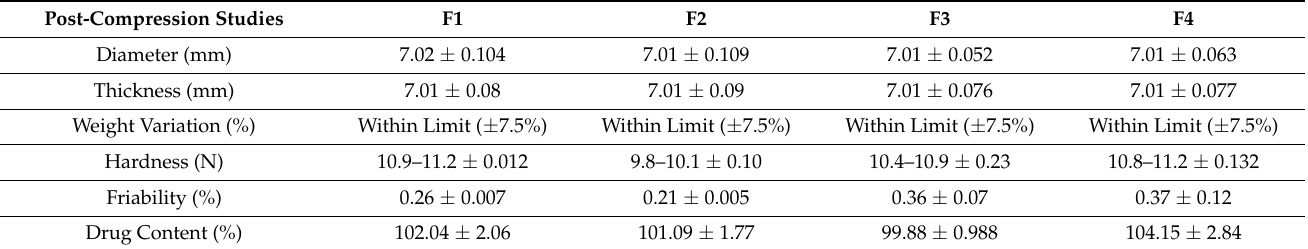
Table 3. Post-compression studies of bilayer